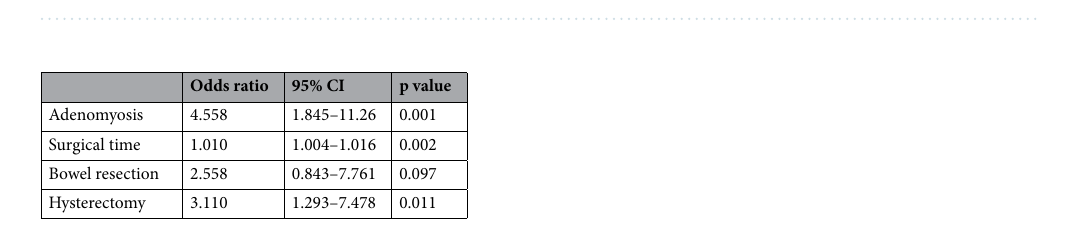
Table 3. Surgical data and complications. Significant values are in bold. Data are given as n or %. SD standard deviation, CD Clavien–Dindo, n number, % percentage.